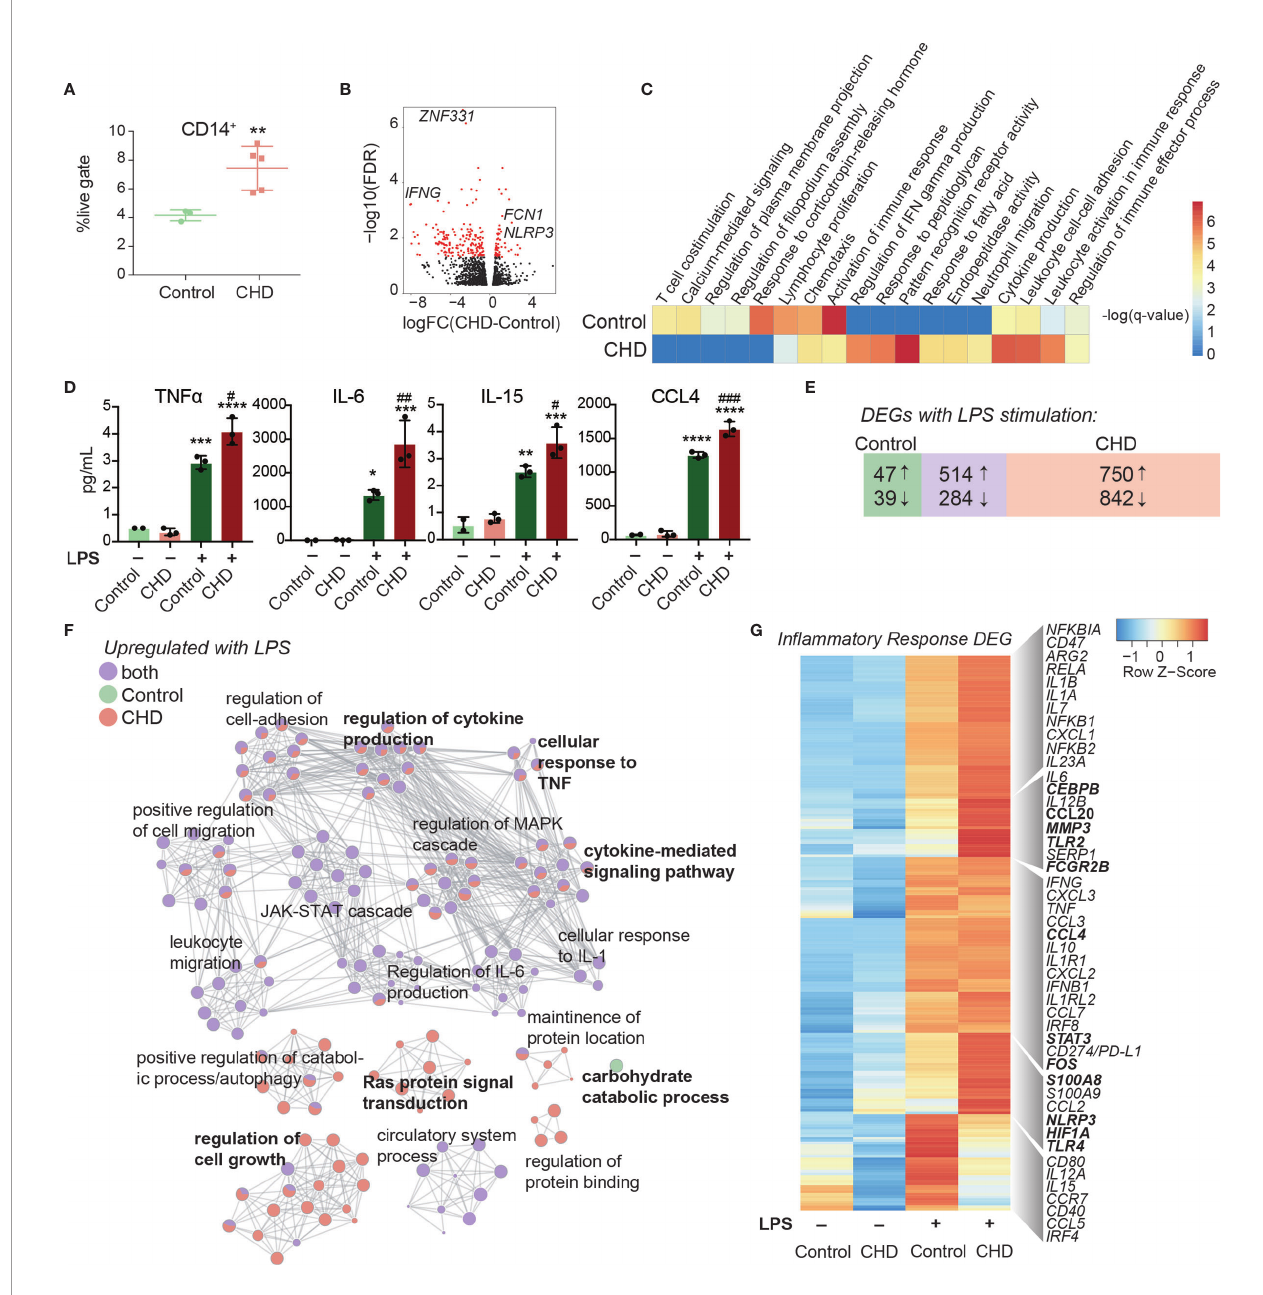
FIGURE 2 | Impact of CHD on the monocyte functional and transcriptomic response to LPS. (A) Abundance of live CD14+ cells in PBMC from control (n = 3) and CHD (n = 5) female macaques measured by fl ow cytometry. Signi fi cance calculated by t-test with Welch ’ s correction. (B) Volcano plot representing up- and downregulated differentially expressed genes (DEG) with CHD in resting monocytes. Red = signi fi cant with an FDR ≤ 0.05 and fold change ≥ 2. (C) Heatmap of signi fi cant GO terms (identi fi ed using Metascape) to which DEGs downregulated and upregulated with CHD in monocytes enriched. The scales of the heatmaps are -log(q-values) associated with the enrichment to selected pathways. (D) Puri fi ed monocytes were stimulated with LPS for 6 hours and supernatants were analyzed by Luminex assay. Bar plots showing concentration (pg/ml) of selected immune mediators (TNF a , IL-6, IL-15, CCL4) (*p < 0.05, **p < 0.01, ***p < 0.001, ****p < 0.0001 between LPS and unstimulated condition, # p < 0.05, ## p < 0.01, ### p < 0.001 between CHD and control for each stimulation condition calculated by One- way ANOVA). (E) Venn diagram showing overlap between DEG identi fi ed in control and CHD monocytes after LPS stimulation. (F) Network visualization of functional enrichment analysis of DEG upregulated with LPS in monocytes from controls only, CHD only, and both using Metascape. The size of each node represents the number of DEGs associated with a given gene ontology (GO) term and the pie chart fi lling represents relative proportion of DEGs from each group that enriched to that GO term. Similar GO terms are clustered together and are titled with the name of the most statistically signi fi cant GO term within that cluster. The gray lines denote shared interactions between GO terms. Density and number of gray lines indicates the strength of connections between closely related GO terms. (G) Heatmap of average normalized expression of genes associated with in fl ammatory response